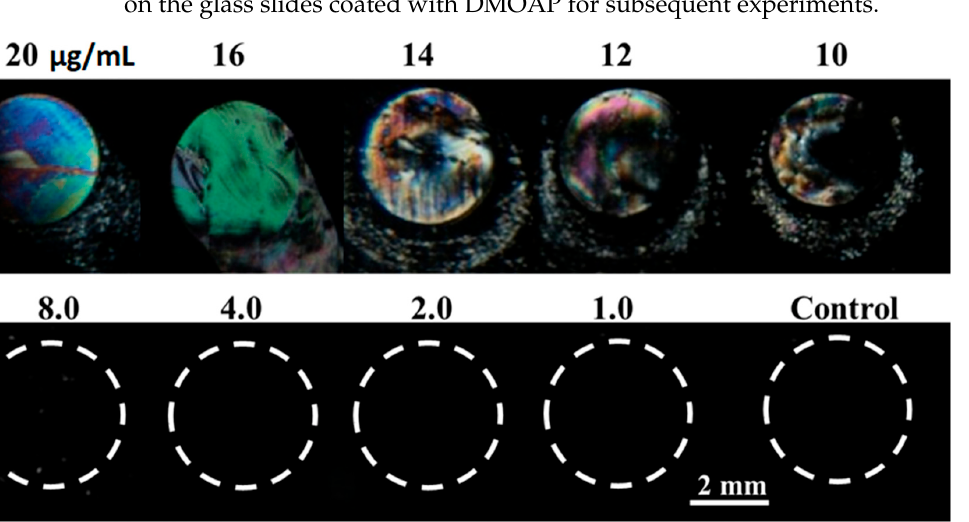
Figure 3. Optical images of LCs supported on a DMOAP-coated slide immobilized with B40t77 aptamer solution with different concentrations; number above each spot is B40t77 aptamer concentration ( µ g/mL), whereas control is just TE buffer without B40t77